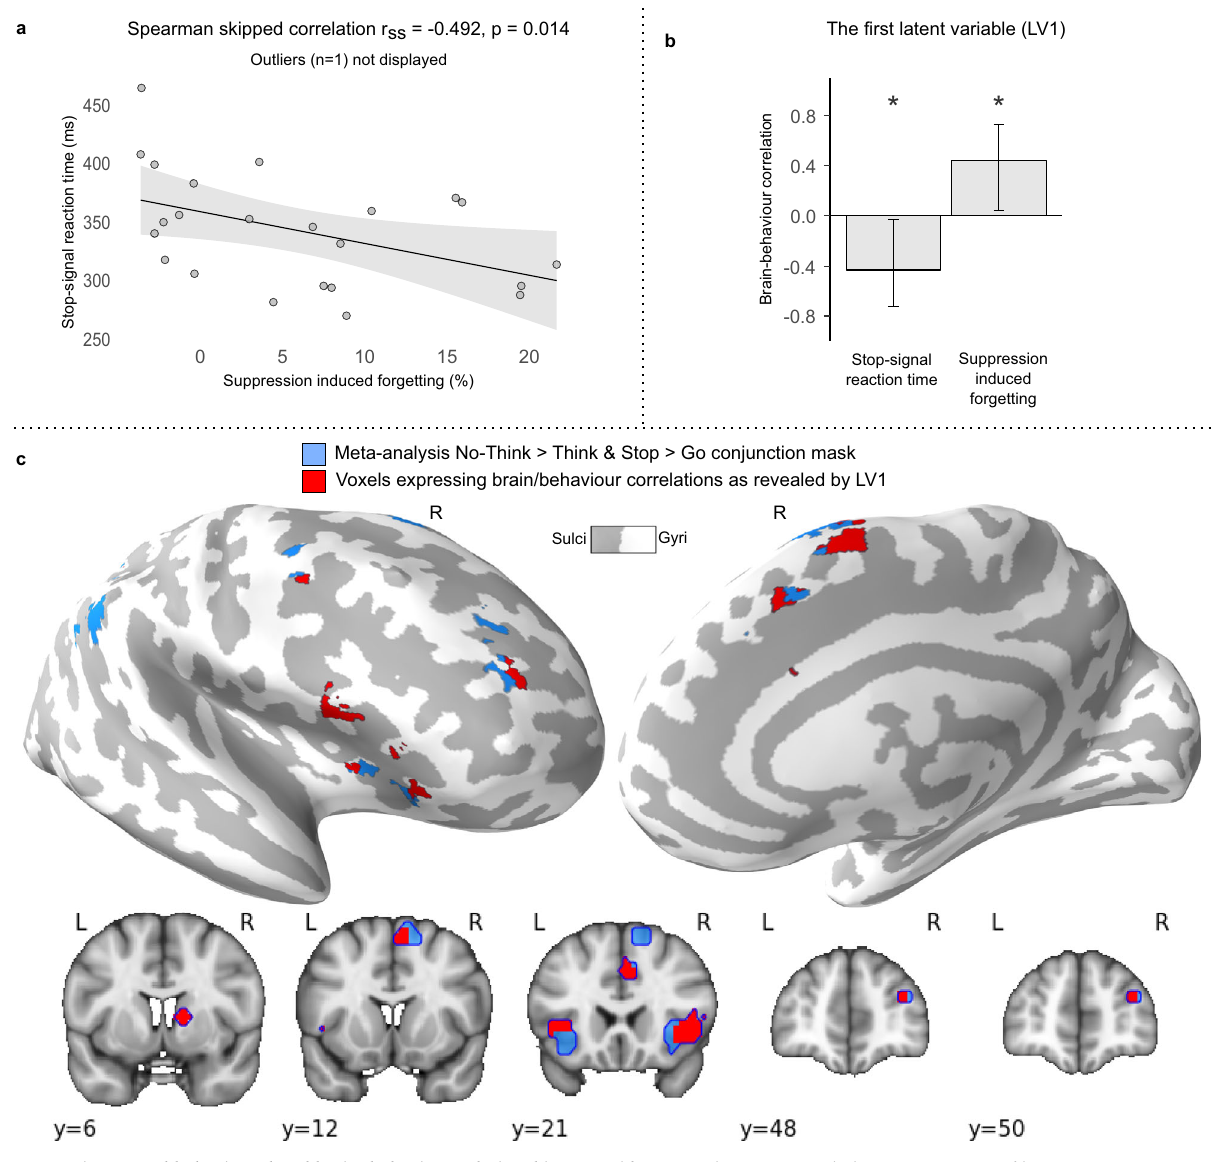
Fig. 4 Domain-general behavioural and brain/behaviour relationships. a and b Source data are provided as a Source Data fi le. a Better action stopping ef fi ciency (shorter stop-signal reaction time) was associated with better inhibitory control over thoughts (percentage of items forgotten for No-Think relative to Baseline conditions at the fi nal recall phase), i.e. suppression-induced forgetting; r ss = − 0.492, p = 0.014, n = 24. One bivariate outlier is not displayed on the scatterplot. Shading represents 95% CI. b and c A behavioural partial least squares (PLS) analysis was conducted to identify brain areas where individual variation in inhibition ability (SSRT and SIF) was related to increased inhibition-induced activity (main effect contrast of inhibition from the within-subject experiment, masked by the meta-analytic conjunction). b The fi rst latent variable (LV1) identi fi ed voxels showing a signi fi cant pattern of brain/behaviour correlations to both SSRT and SIF (error bars indicate bootstrapped 95% CI, n = 5000, * p < 0.05). c The voxel salience map expressing LV1. Blue: meta-analytic conjunction mask. Red: voxels showing a signi fi cant pattern of brain/behaviour correlations as revealed by the LV1; thresholded at bootstrapped standard ratio 1.96, corresponding to p < 0.05, two-tailed. Results are displayed on an in fl ated MNI- 152 surface (top panel), as well as on MNI-152 volume slices (bottom panel). R: right hemisphere; L: left hemisphere. The brain images were generated using FreeSurfer software (http://surfer.nmr.mgh.harvard.edu), and PySurfer (https://pysurfer.github.io) and Nilearn (https://nilearn.github.io) Python (Python Software Foundation, DE, USA) packages. Conjunction mask, PLS results and visualisation notebook are available on the GitHub repository 104 domain-speci fi c output features in that the latter govern the interaction of the stopping mechanism with posterior-cortical or subcortical target regions, whereas the former re fl ect computa- tions speci fi c to a stopping domain that are local to the prefrontal source region. Domain-general stopping features should yield